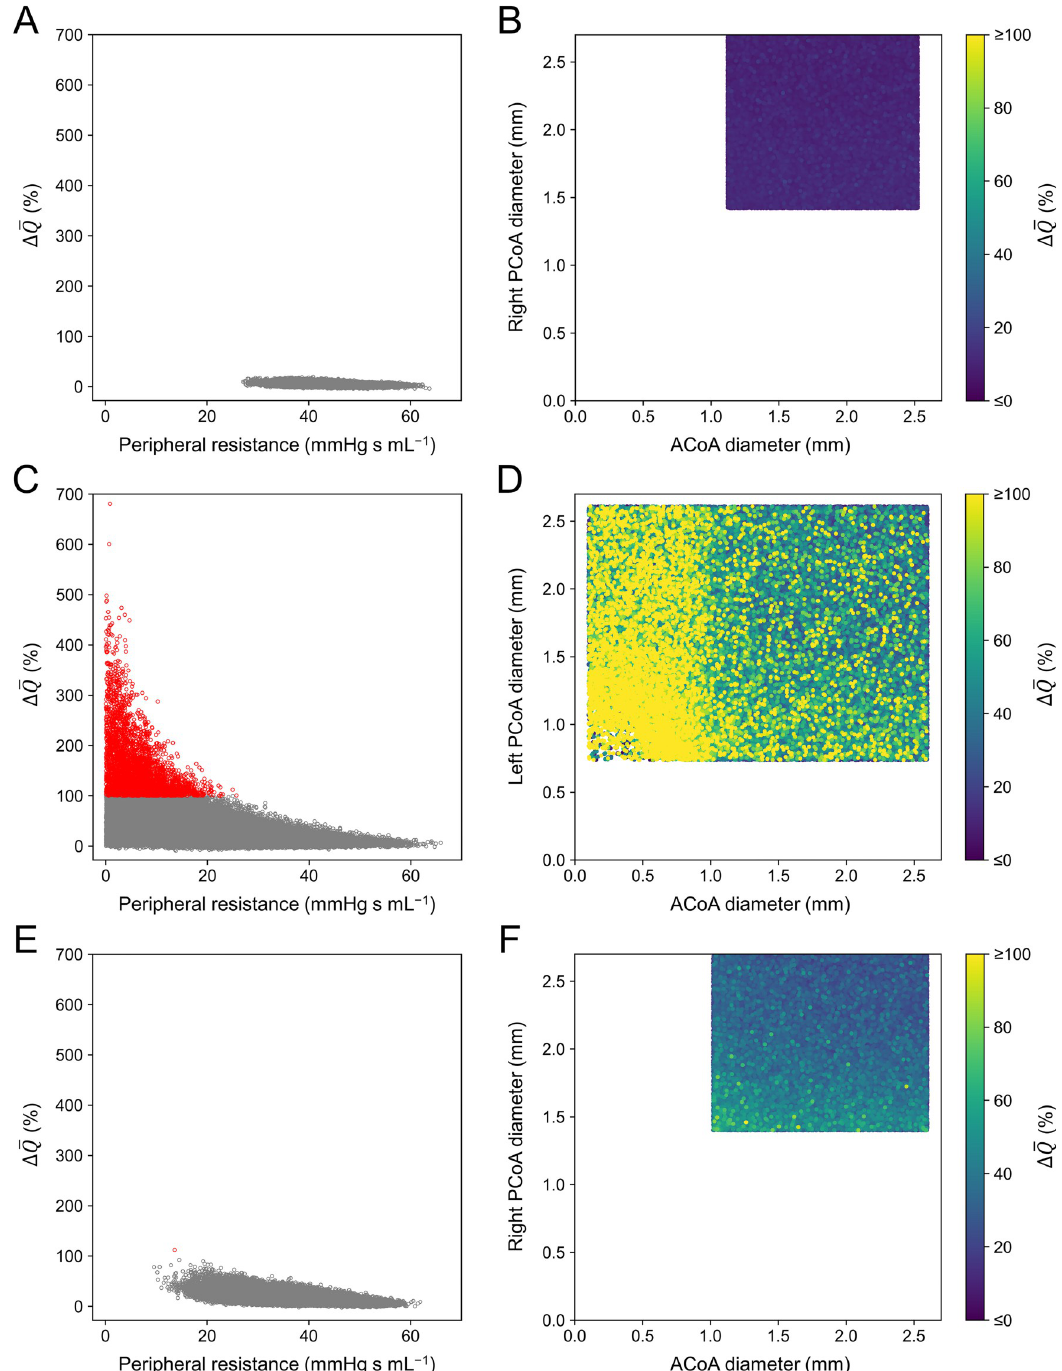
Fig 9. Postoperative flow increase ( D � Q ) in Patients 1–3 relative to several factors. Left column: scatter plot of D � Q at the middle cerebral artery on the stenosis side with respect to the adjusted preoperative peripheral resistance of this artery. Samples with D � Q > 100% are indicated in red. Right column: D � Q with respect to the diameters of the anterior communicating artery (ACoA) and posterior communicating artery (PCoA) that form the collateral pathway to the artery on the stenosis side. Samples with D � Q > 100% are depicted in yellow, regardless of their value. (A) (B) Patient 1; (C) (D) Patient 2; and (E) (F) Patient 3.